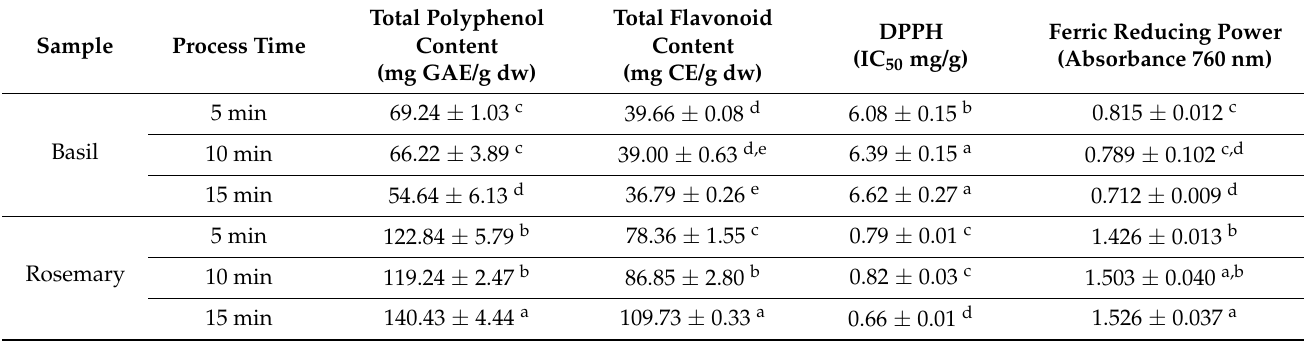
Table 1. Effect of boiling on the bioactive properties of basil and